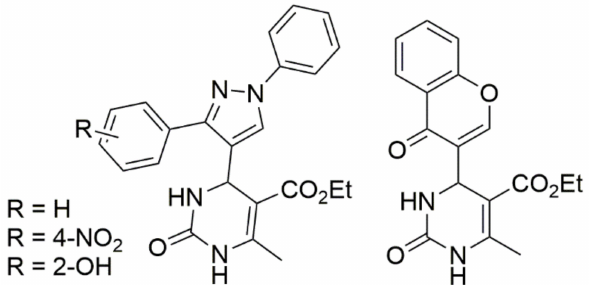
Figure 8. Biginelli products synthesized by Wageeh S. El-Hamouly et al. for their anti-hypertensive